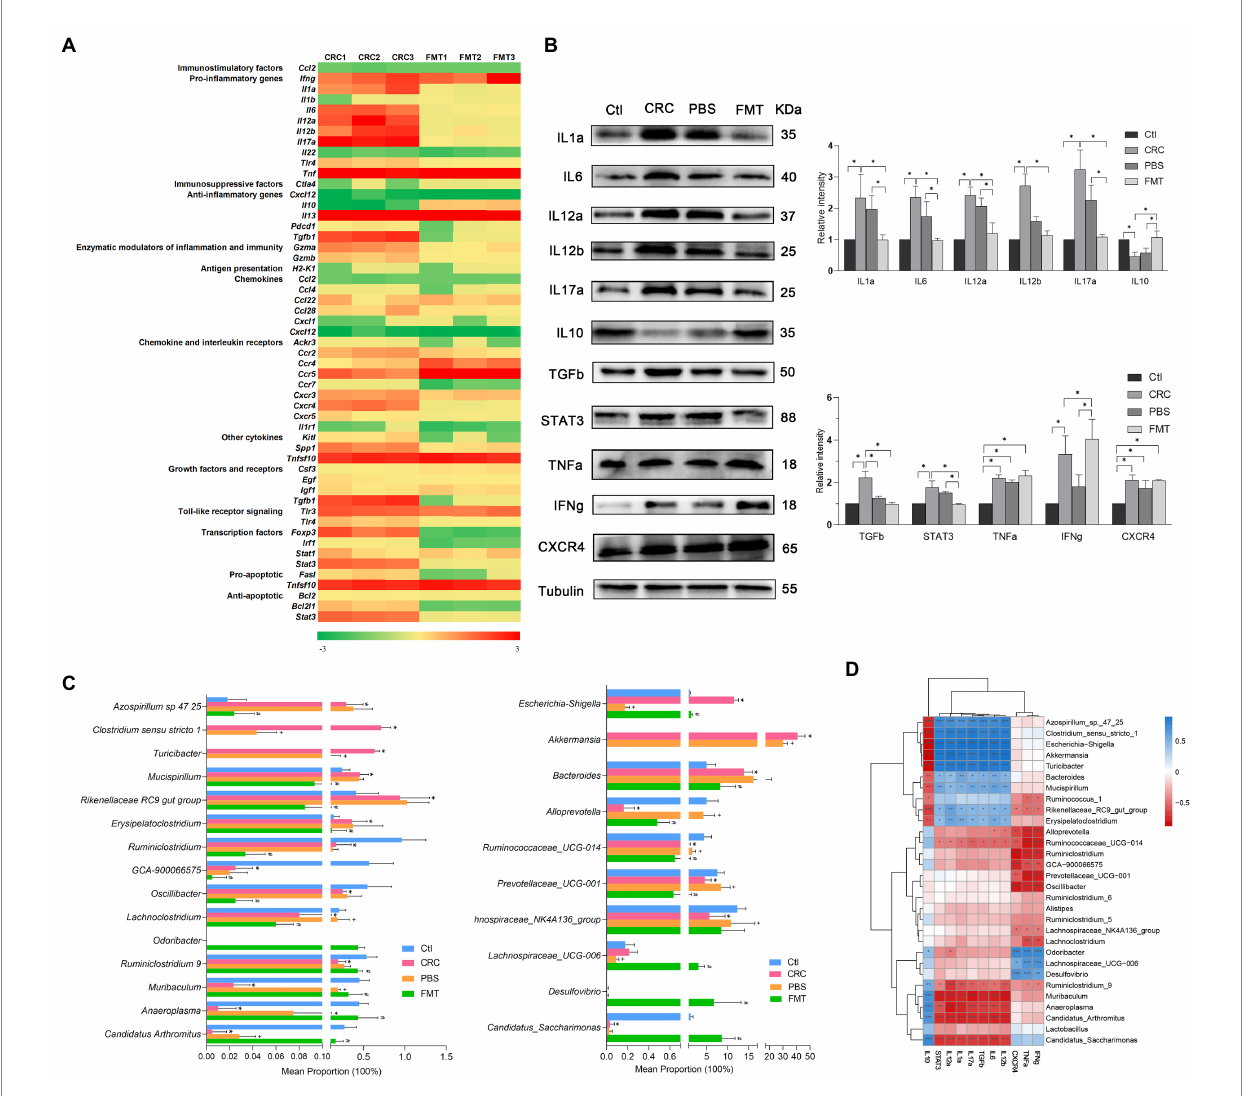
FIGURE 4 FMT regulated the expressions of cytokines in CRC microenvironment to enhance anti-inflammatory and anti-cancer efficacy. (A) PCR array analysis of cytokines within CRC microenvironment. (B) Protein images of differentially expressed cytokines screened by gene chip; the relative protein expressions of inflammatory cytokines IL1a, IL6, IL12a, IL12b, IL17a, IL10 and anti-cancer immunoregulatory factors TGFb, STAT3, TNFa, IFNg and CXCR4. * p < 0.05, n = 3. (C) The abundance of intestinal microbe related to inflammatory cytokines and anti-cancer immune molecules. * p < 0.05, Ctl vs. CRC, + p < 0.05, CRC vs PBS, # p < 0.05, PBS vs FMT, n = 6. (D) Correlation analysis between intestinal microbiota and cytokines. * p < 0.05, ** p < 0.01, *** p < 0.001, n =